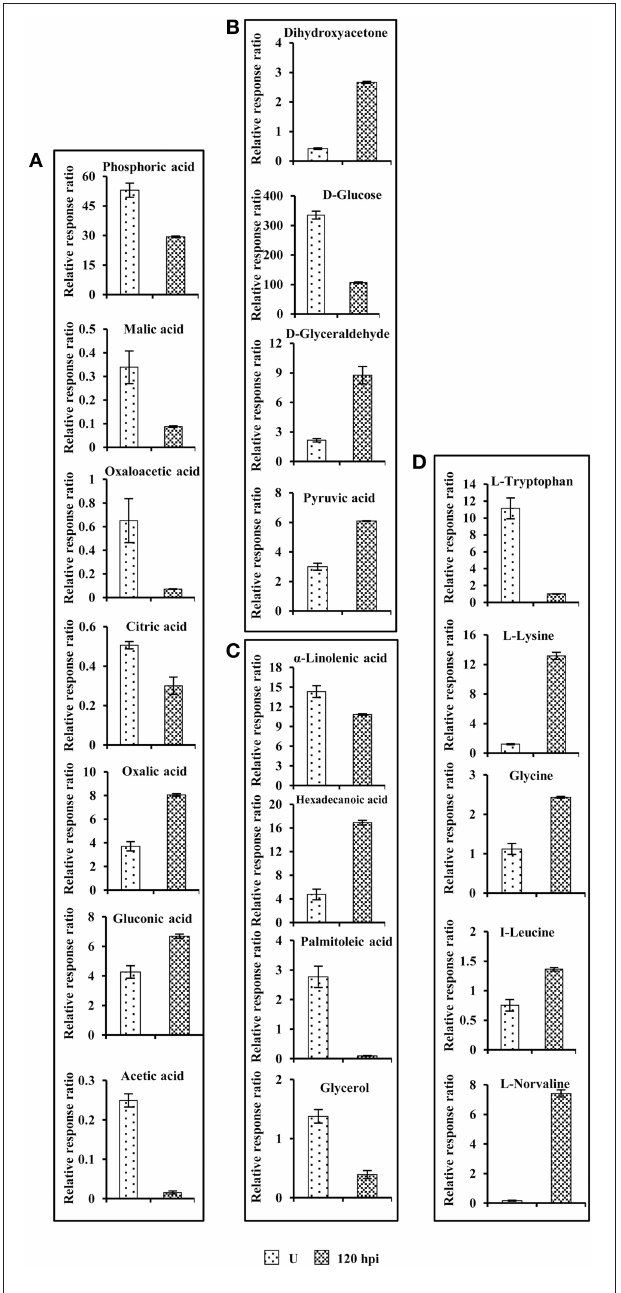
FIGURE 6 | Comparison of primary metabolite levels in unstressed tomato fruits with those in tomato fruits challenged with Sclerotinia rolfsii at 96 hpi. (A) Organic acids, (B) Carbohydrates, (C) Fatty acids and, (D) Aminoacids. Data are normalized to the mean response calculated for unstressed levels of each replicate (to allow comparison between replicates, individual values were normalized in same way). Values presented are the mean ± SD of four independent